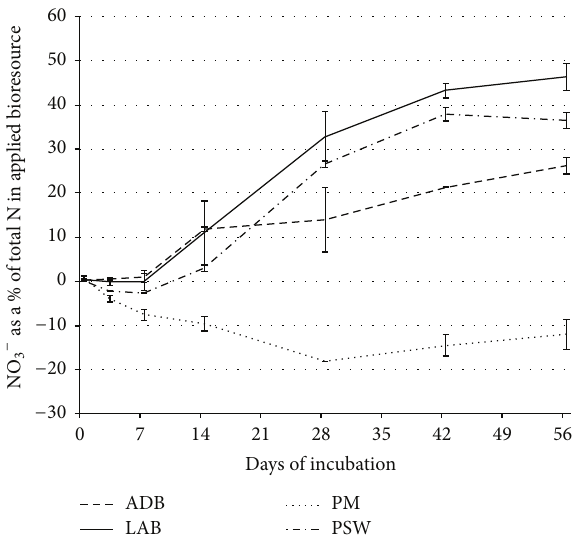
Figure 2: NH 4+ concentration of treated soils (dry weight) as percentage of total N of added amendment (error bars are standard error of the means). Corrected for NH 4+ in control soil.